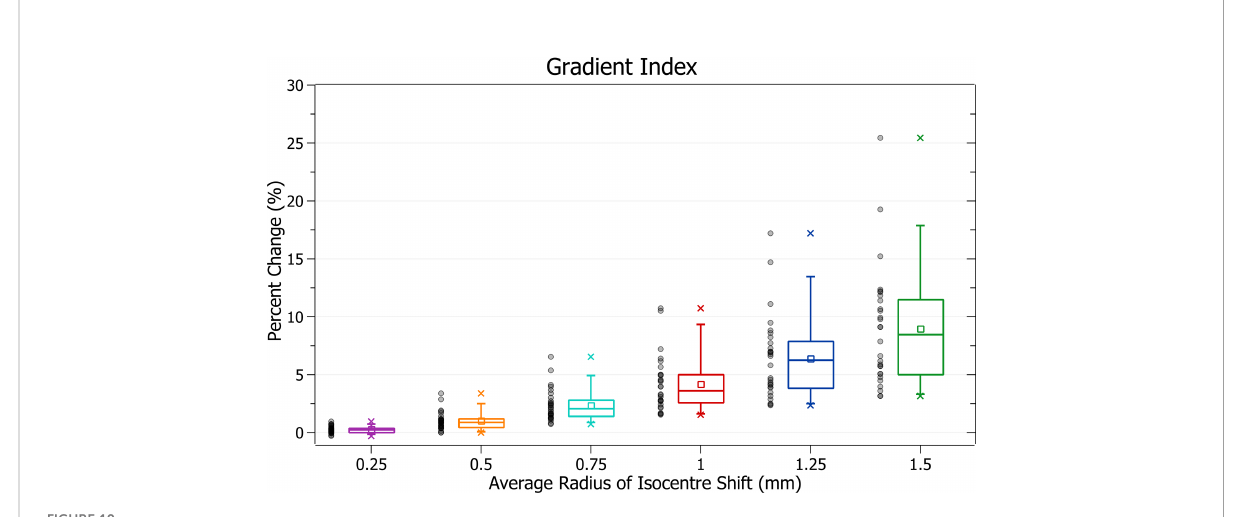
FIGURE 10 Percentage change of gradient index for different radii of isocentre shift.